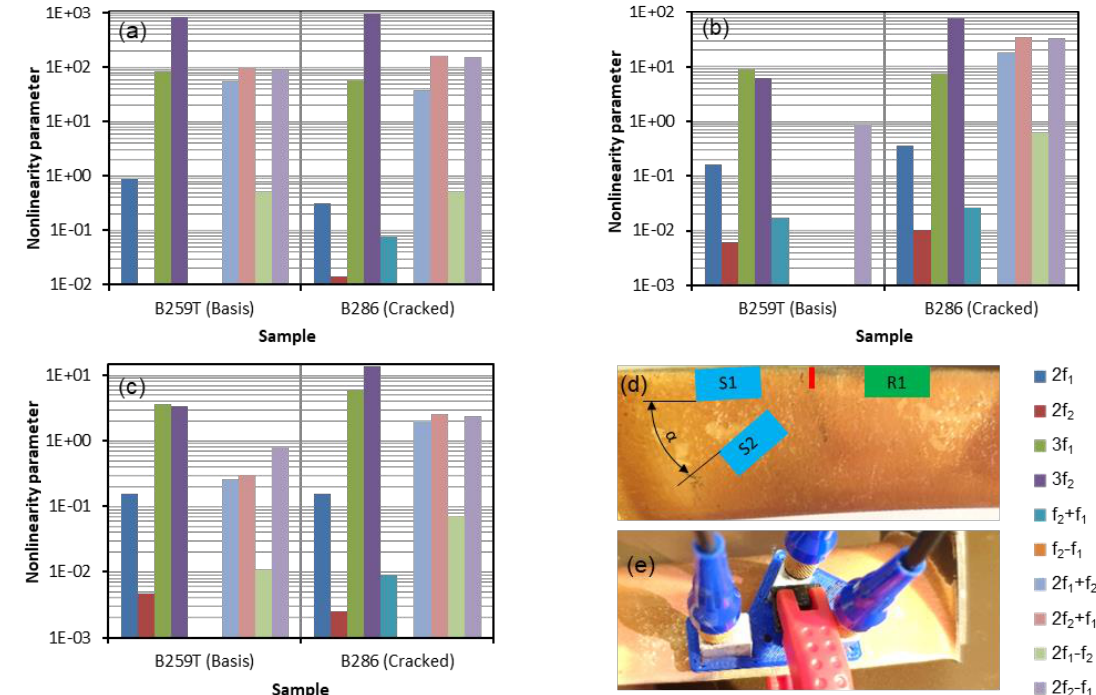
Figure 33. Nonlinearity parameter: ( a ) f 1 = 4 MHz, f 2 = 5 MHz, α = 45°; ( b ) f 1 = 4 MHz, f 2 = 5 MHz, α = 60°; ( c ) f 1 = 4 MHz, f 2 = 5 MHz, α = 90°; ( d ) Sensor orientation; ( e ) Experimental setup.